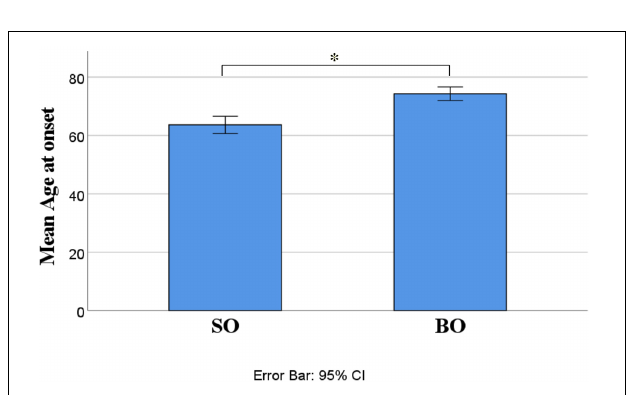
FIGURE 1 | ALS site of onset compared for mean LogNfL levels. Mean LogNfL was higher in BO than SO (2.21 + 0.32 versus 1.87 + 0.27 pg/mL; p = 0.020). Abbreviations: LogNfL, log of NfL concentration; SO, spinal onset; BO, bulbar onset.